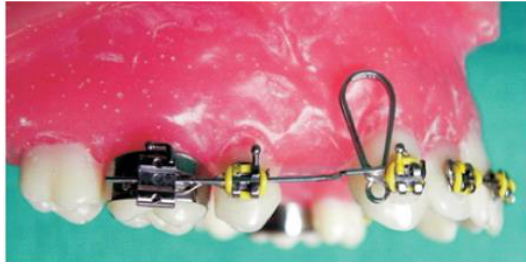
Figure 8: PG retraction spring